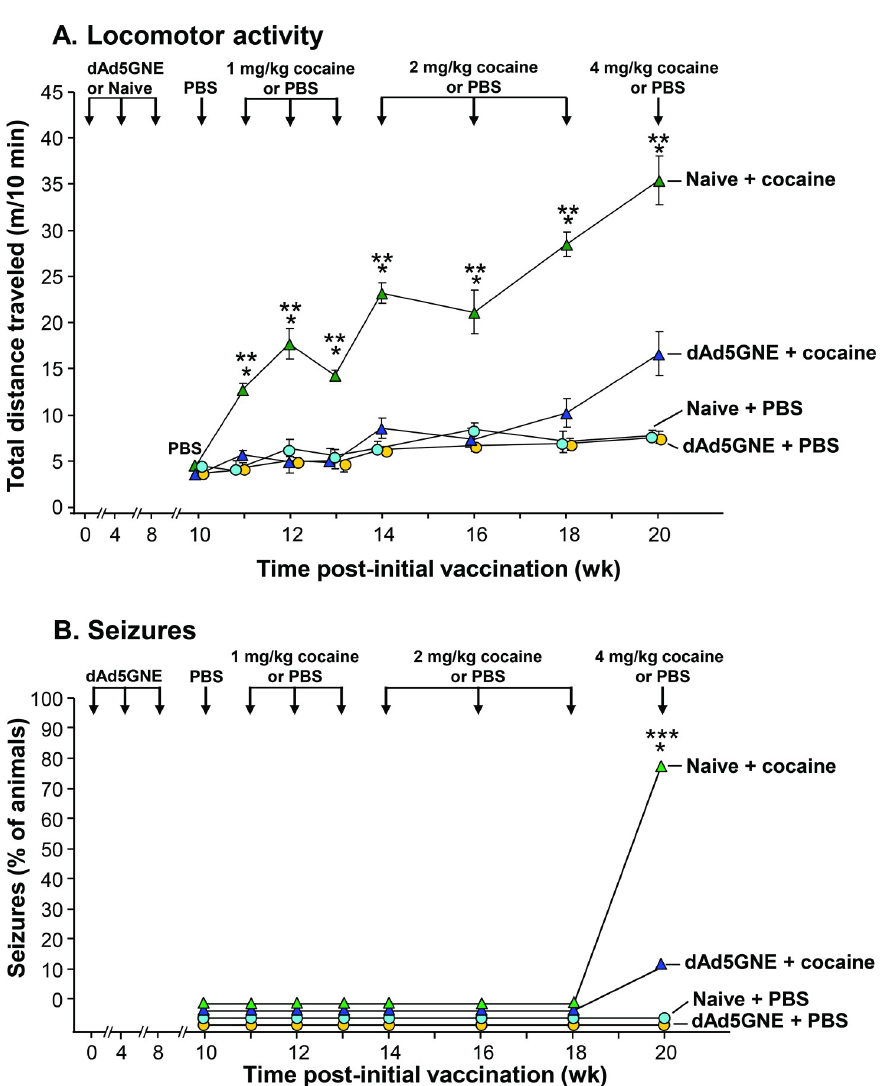
Fig 2. Vaccination with dAd5GNE reduces cocaine-induced hyperactivity and toxicity following repeated high- dose cocaine use. A. Total distance traveled. Mice were challenged with PBS 10 wk following initial vaccine administration, and then with PBS or cocaine (1 mg/kg on wk 11, 12, and 13; 2 mg/kg on wk 14, 16, and 18, 4 mg/kg on wk 20). The locomotor activity of naive and dAd5GNE vaccinated mice following each challenge is shown as mean total distance traveled in 10 min ± SE. Groups are compared by two-tailed unpaired t-tests. B. Seizure activity. The percentage of naive and dAd5GNE vaccinated mice experiencing a seizure following each challenge is shown as the percentage of animals experiencing a seizure within 10 min of administration. Groups are compared by one-tailed Barnard’s test. Naive + cocaine (green triangle; n = 5), dAd5GNE + cocaine (blue triangle; n = 10), naive + PBS (teal circle; n = 5), dAd5GNE + PBS (yellow circle; n = 10). � denotes p < 0.05 for naive + cocaine vs naive + PBS. �� denotes p < 0.05 for naive + cocaine vs dAd5GNE + cocaine in panel A. ��� denotes p < 0.01 for naive + cocaine vs dAd5GNE + cocaine in panel B. There were no significant differences between the dAd5GNE + cocaine and naive + PBS groups at any timepoint. There were no significant differences between the dAd5GNE + cocaine and dAd5GNE + PBS groups at any